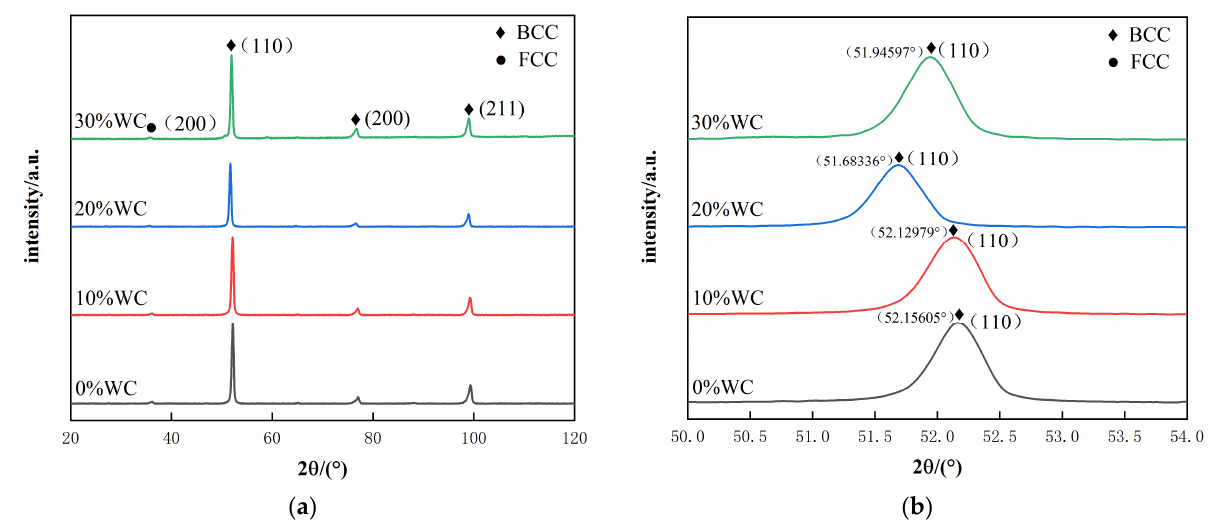
Figure 3. XRD image: ( a ) XRD patterns of AlCoCrFeNi(WC) x alloys; ( b ) the detailed scans for the peak of (110) of BCC solid solution phase.